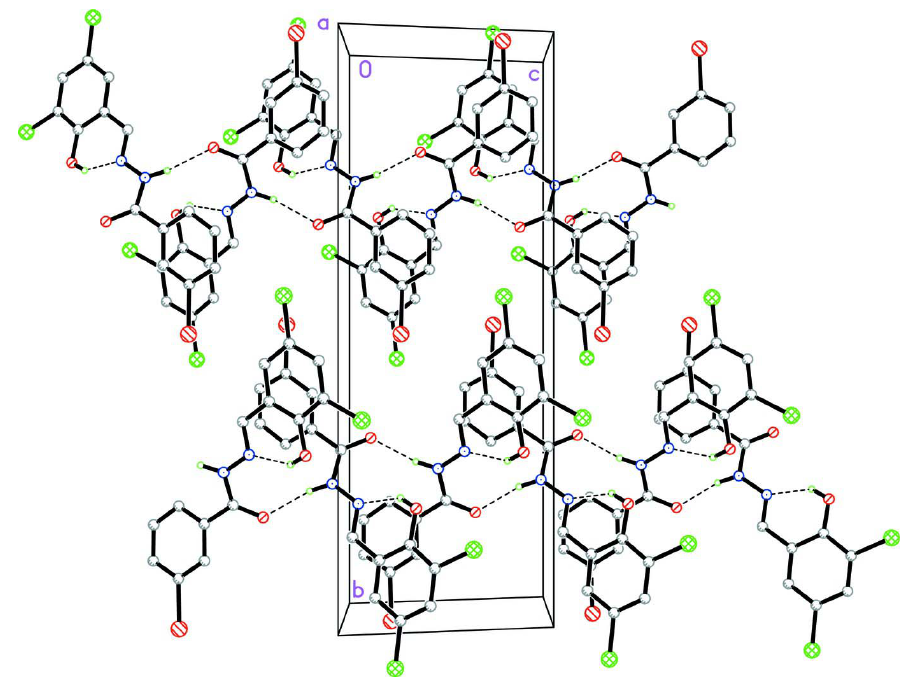
Figure 2 Molecular packing of the title compound, viewed along the a axis. Hydrogen bonds are shown as dashed